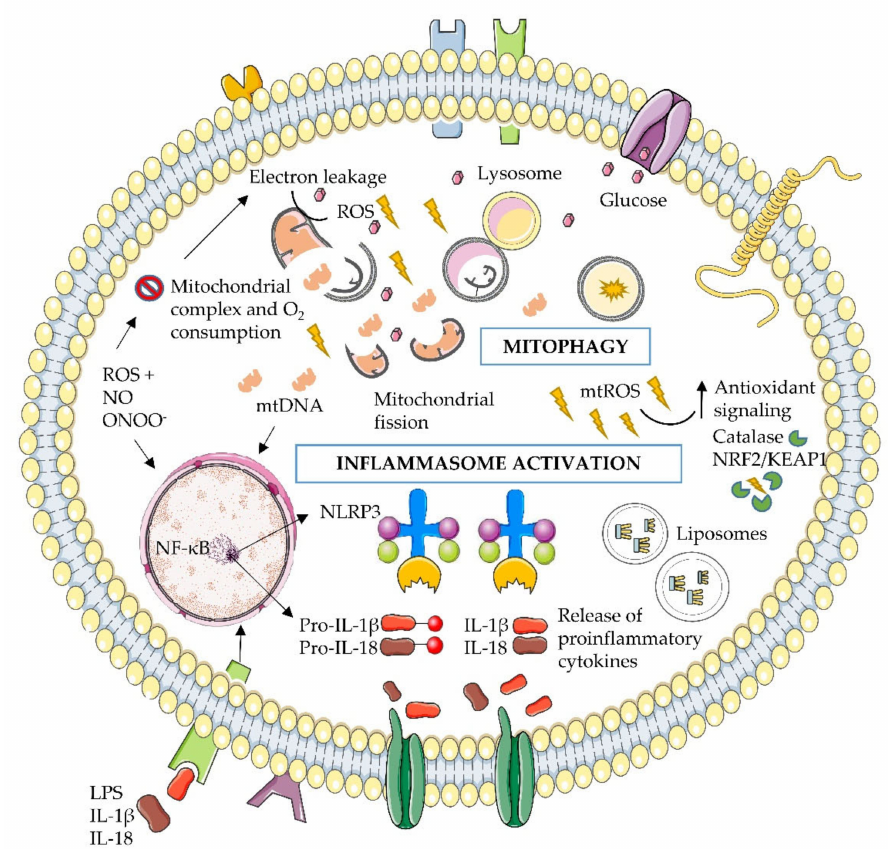
Figure 1. General mechanisms of ROS-induced mitochondrial dysfunction in obese and type 2 diabetes (T2D) patients. Dysregulated / impaired systemic inflammation, glucotoxicity and lipotoxicity triggers mtROS and RNS generation by mitochondrial ETC. Nitrosative stress also inhibits mitochondrial complexes and O 2 consumption, as it is more reactive to ROS. As a result, the cytokines pro-IL-1 β and pro-IL-18 and the inflammasome complex are activated through NF- к B translocation in the nucleus. Moreover, mtROS stimulates an increase in antioxidant defense signaling in order to modulate oxidative stress homeostasis. Disrupted mitochondria are targeted by autophagosomes in a process called mitophagy, which aims to restore the mitochondrial function. Abbreviations: ETC, electron transport chain; IL-1 β , interleukin-1 β ; IL-18, interleukin-18; KEAP1, Kelch-like ECH-associated protein 1; mtROS, mitochondrial ROS; NF- к B, nuclear factor kappa-light-chain-enhancer of activated B cells; NRF2, nuclear factor erythroid 2-related factor 2; RNS, reactive nitrogen species; NO, nitric oxide; ONOO-, peroxynitrite; NLRP3, NLRP3 (nucleotide oligomerization domain (NOD), leucine-rich repeat (LRR) and pyrin domain (PYD)) and ROS, reactive oxygen